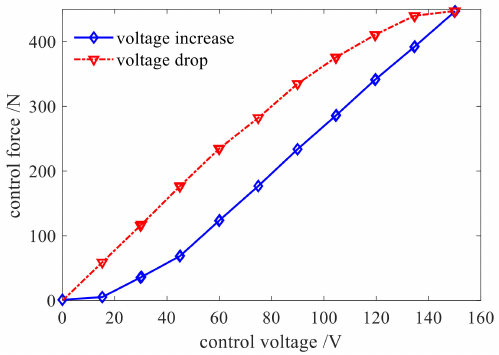
Figure 12. Relationship between control force and control voltage of the Smart Spring